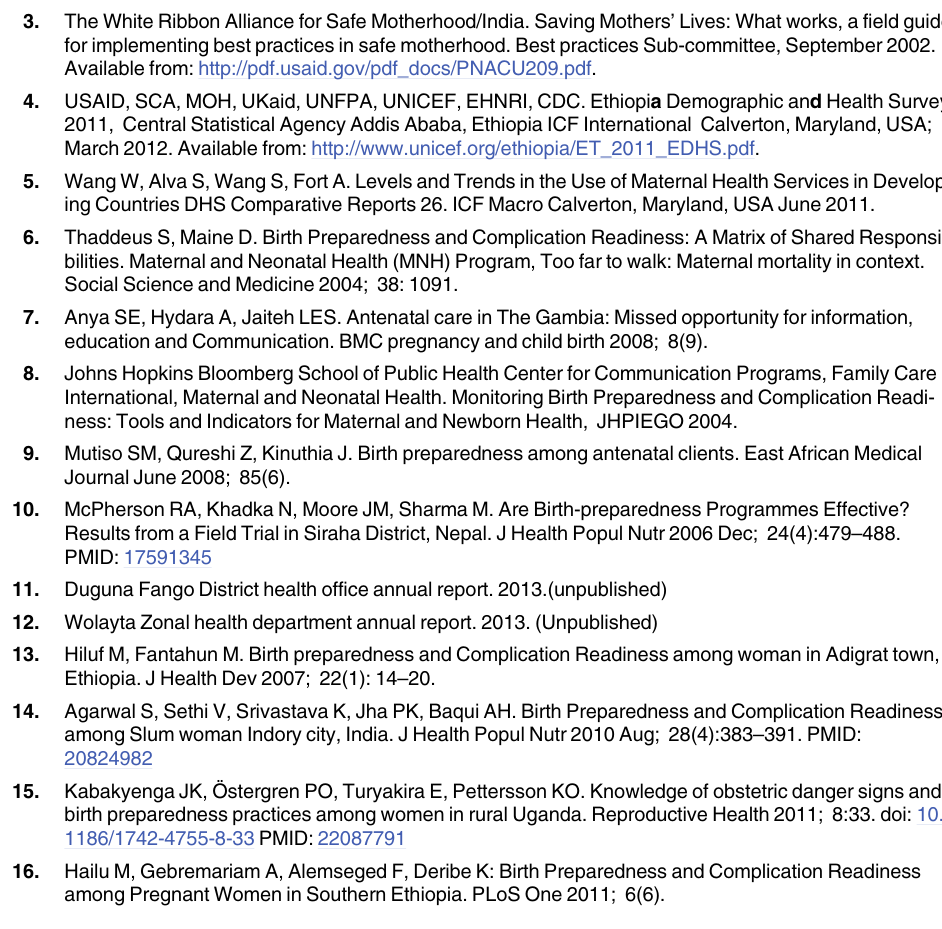
PLOS ONE | DOI:10.1371/journal.pone.0137570 September 17,